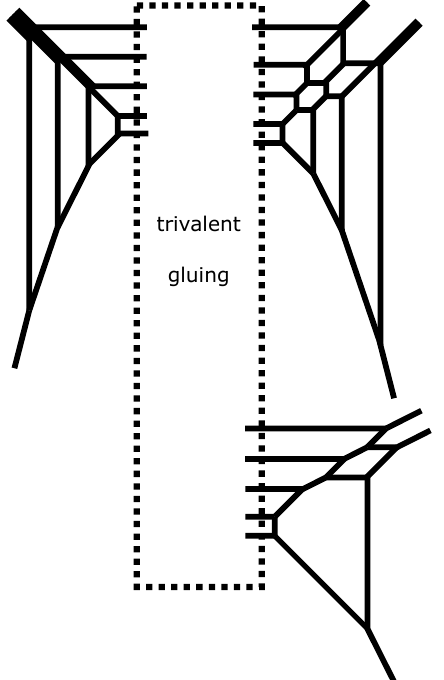
Figure 20. (a): The web diagram of the theory obtained after the Higgsing (4 , 4 , 2) . (b): The Dynkin diagram of the twisted affine Lie algebra e (2) ure 20(a). Each line in non-black color in figure 13(a) corresponds to the node in the same color in this figure.